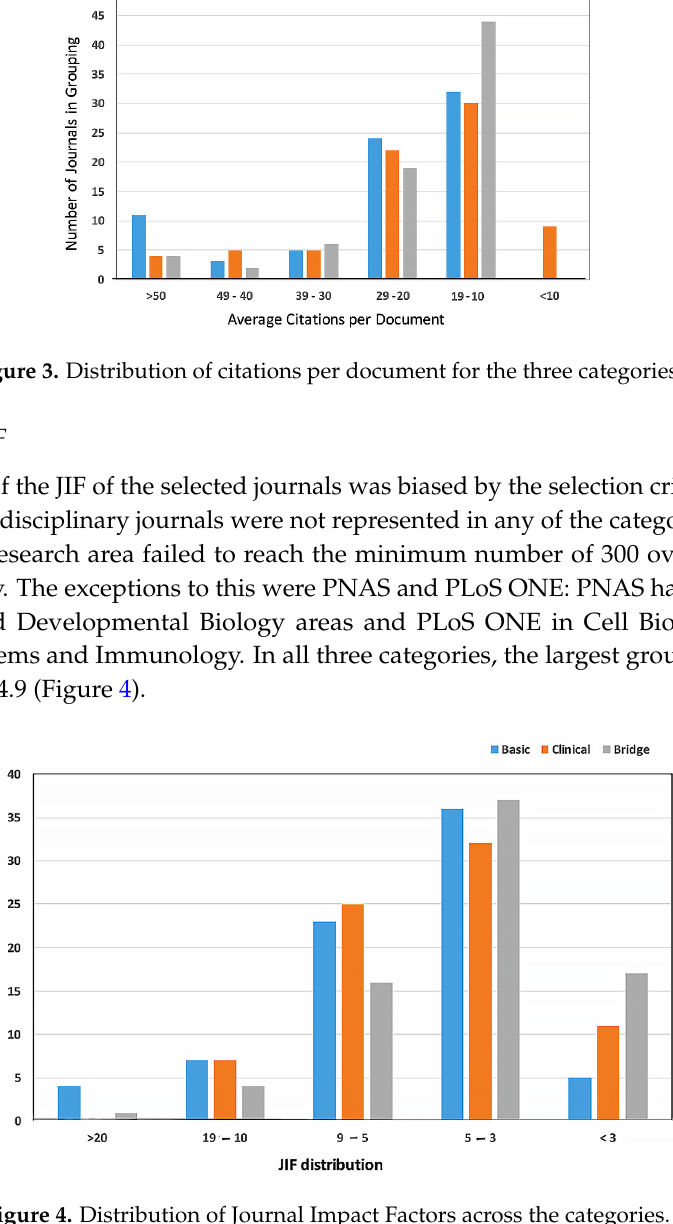
Figure 4. Distribution of Journal Impact Factors across the categories.